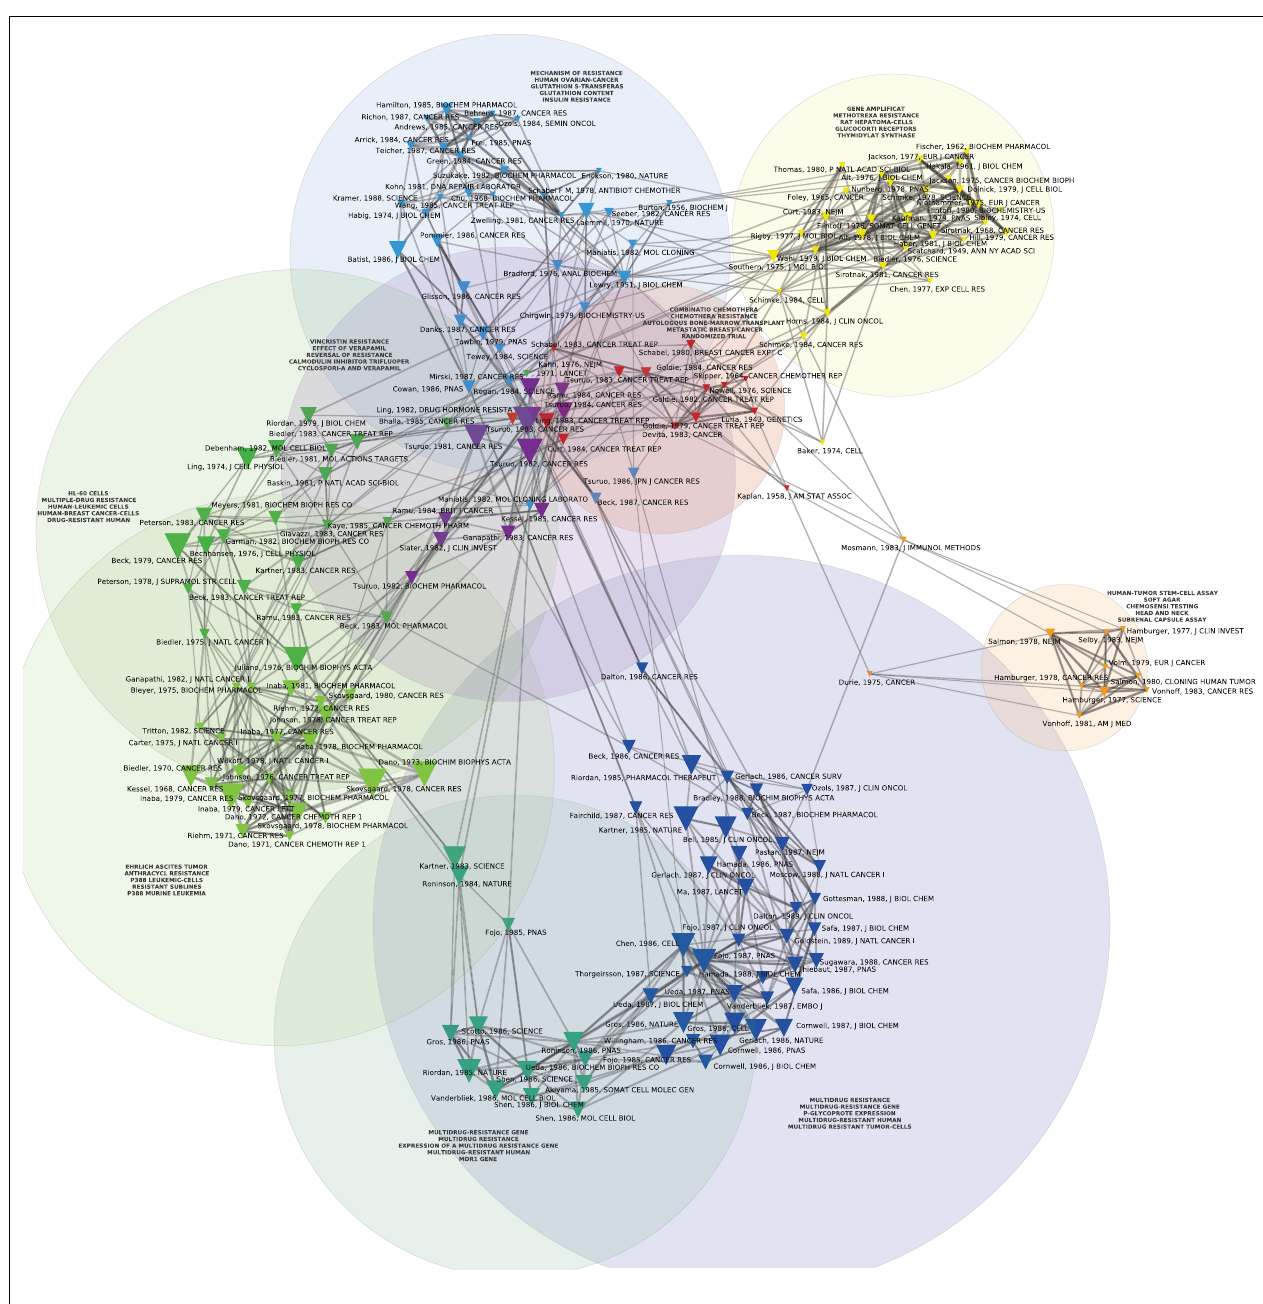
cohesive, color-coded sub-groups that provide a high-level description of the different thematic domains characterizing the field development. Natural-language processing algorithms are used to extract multi-term concepts from the titles and abstracts of the citing references, and the most specific multi-terms (as defined by a Chi-square measure) are used to tag each cluster, thus providing information about the thematic content of that